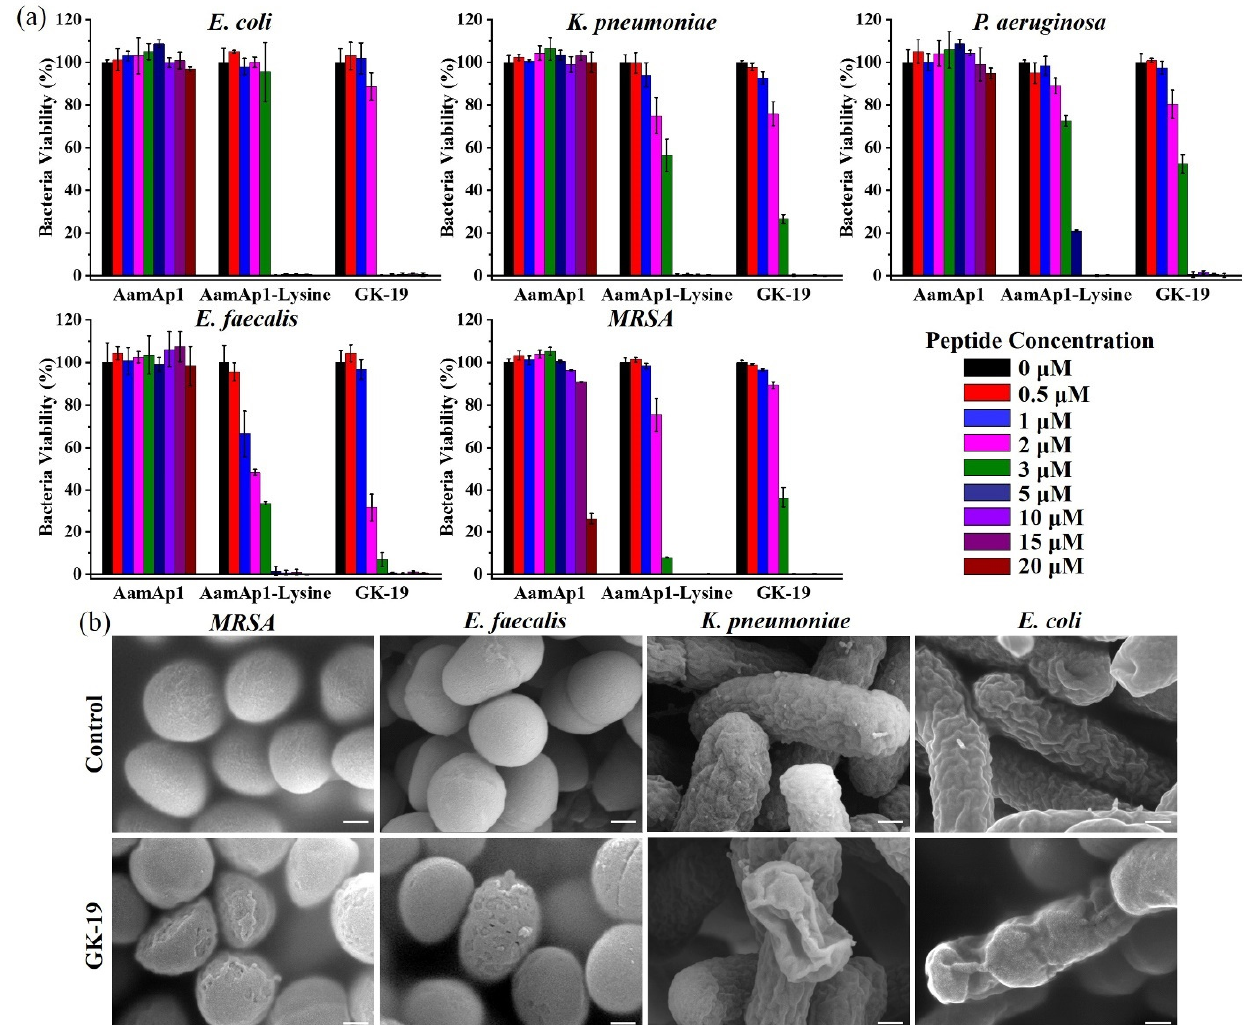
Figure 1. Antibacterial activity of AamAP1, AamAP1-Lys and GK-19. ( a ) Dose-dependent survival of E. coli , K. pneumoniae , P. aeruginosa , E. faecalis and MRSA treated with different antimicrobial peptides for 12 h. Bacteria (1 × 10 6 CFU/mL) were incubated with the peptides at concentrations varying from 0 to 20 μ M. (n = 5) ( b ) SEM images of different bacteria after 2 h of incubation with GK-19 at a concentration of 50 μ M. Scale bar: 200 nm.